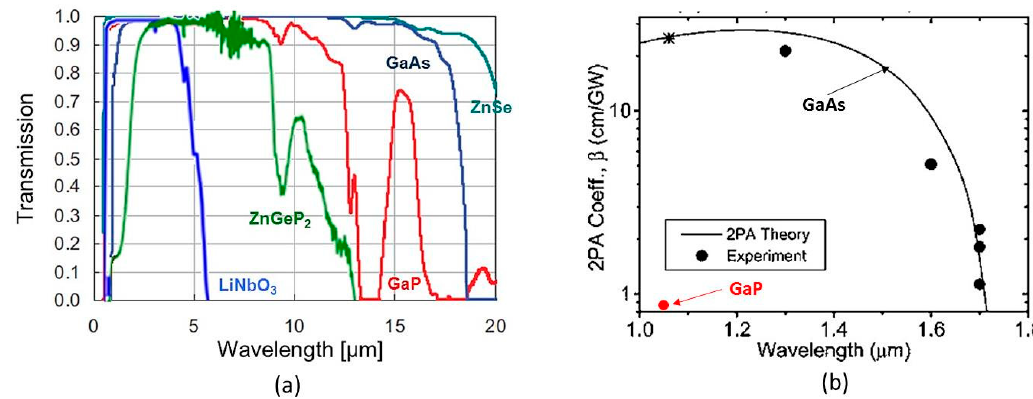
Figure 9. ( a ) IR transparency of some traditional quasi-phase-matching (QPM) nonlinear optical materials [43]; (Reproduced from [43] with some modifications with the permission of SPIE); ( b ) A comparison of the two-photon absorption (2PA) coefficient β of GaAs and GaP in the near IR region between 1–1.7 µm. Initial measurements of 3PA in GaP (not shown here) indicate almost undetectably low numbers [44]. (Reproduced from [44] with some modifications with the permission of OSA).